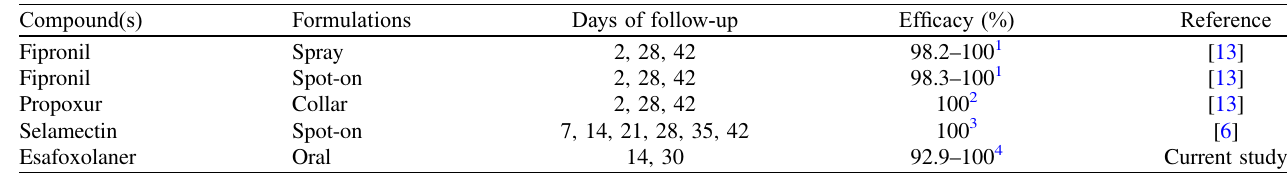
Table 1. Overview of the ef fi cacy fi eld studies of various antiparasitic products against Felicola subrostratus. Compound(s)